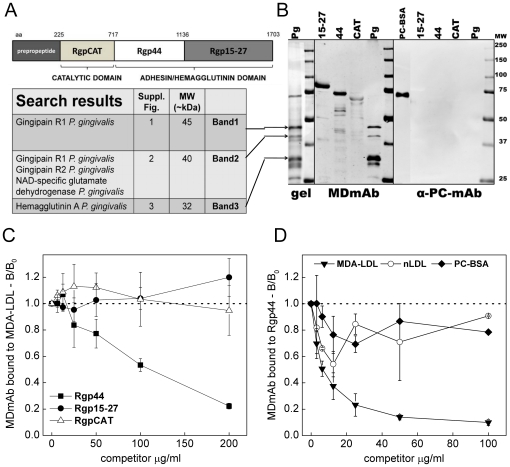
Identification of P. gingivalis epitopes for anti-MDA-LDL-IgM.A) Schematic presentation of arg-gingipain (RgpA) functional domains cloned and produced in a recombinant system [41]. B) Proteins of P. gingivalis were separated on SDS-PAGE (Pg, gel). Fragments recognized by MDmAb (45, 40 and 32 kDa, black arrows) were identified by mass spectrometry as arginine-specific gingipain or hemagglutinin A of P. gingivalis. Figures S1, S2, S3 contain the Mascot results of the database searches and the MSMS spectrum showing the matching amino acids in the peptide sequence. Three domains of the recombinant arg-specific gingipain, RgpCAT, Rgp44 and Rgp15–27 were produced in E. coli and analyzed for recognition by MDmAb and anti-PC-IgM control antibody (α-PC-mAb). C) Specific binding of MDmAb to recombinant gingipain domains Rgp15–27, Rgp44 and RgpCAT was tested with a competitive immunoassay. D) Reciprocally, soluble MDA-LDL, nLDL and PC-BSA were used as competitors for MDmAb binding to Rgp44. B/B0 indicates the ratio of IgM binding with and without a competitor. MW, molecular weight. PC-BSA, phosphocholine-conjugated bovine serum albumin.